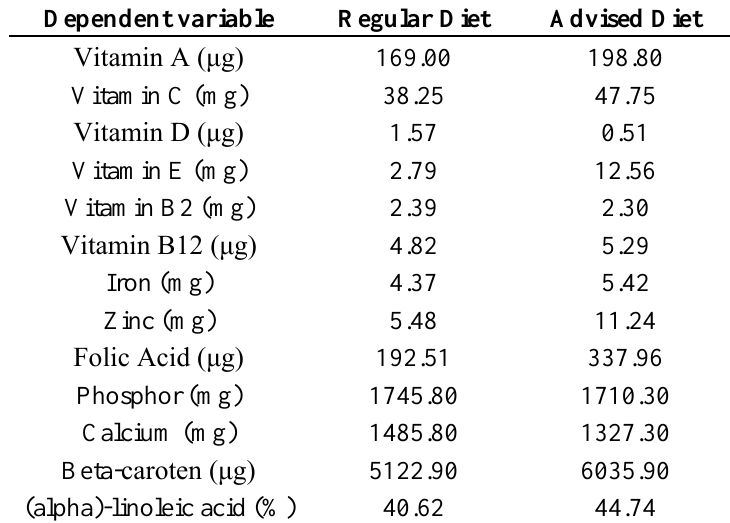
Table 1. Comparison regular diet and advised diet based on regular dietary intake for a child 7 years of